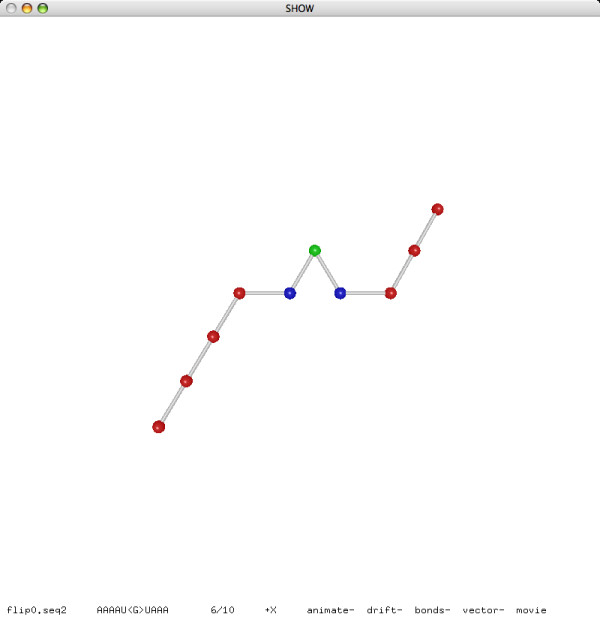
A flip move (before).